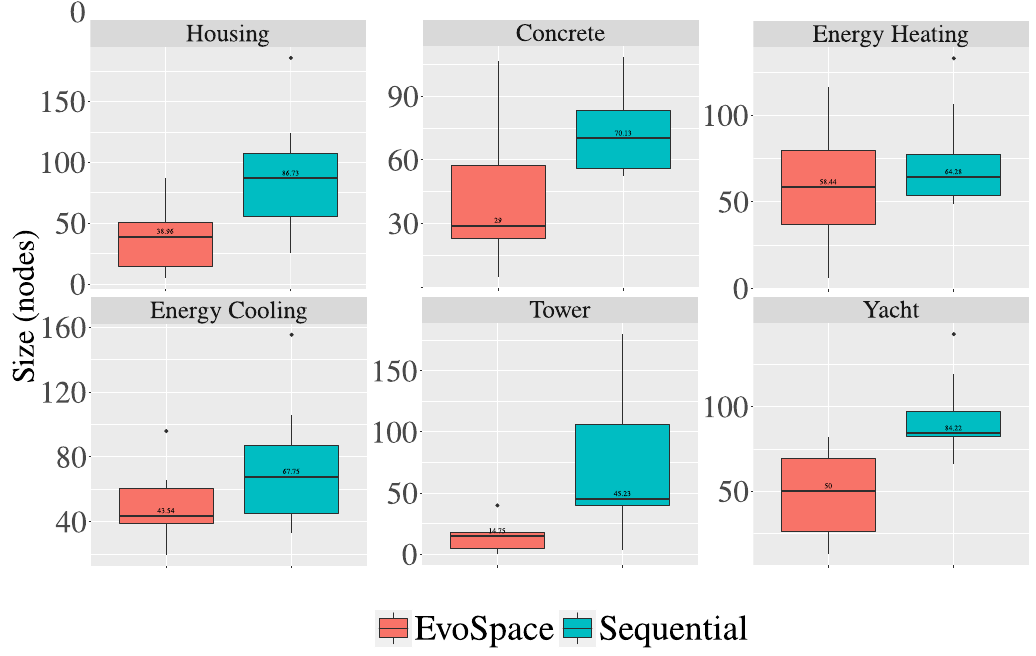
Figure 9. Box plot comparison of the sequential and the EvoSpace implementation of the neat-GP-LS algorithm on the average size of individuals given in number of